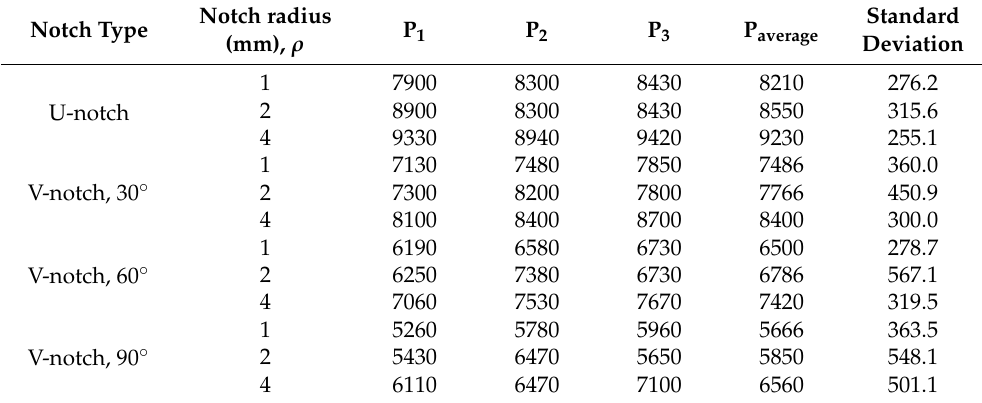
Table 4. Experimental fracture loads (N) of quasi-isotropic composite Brazilian